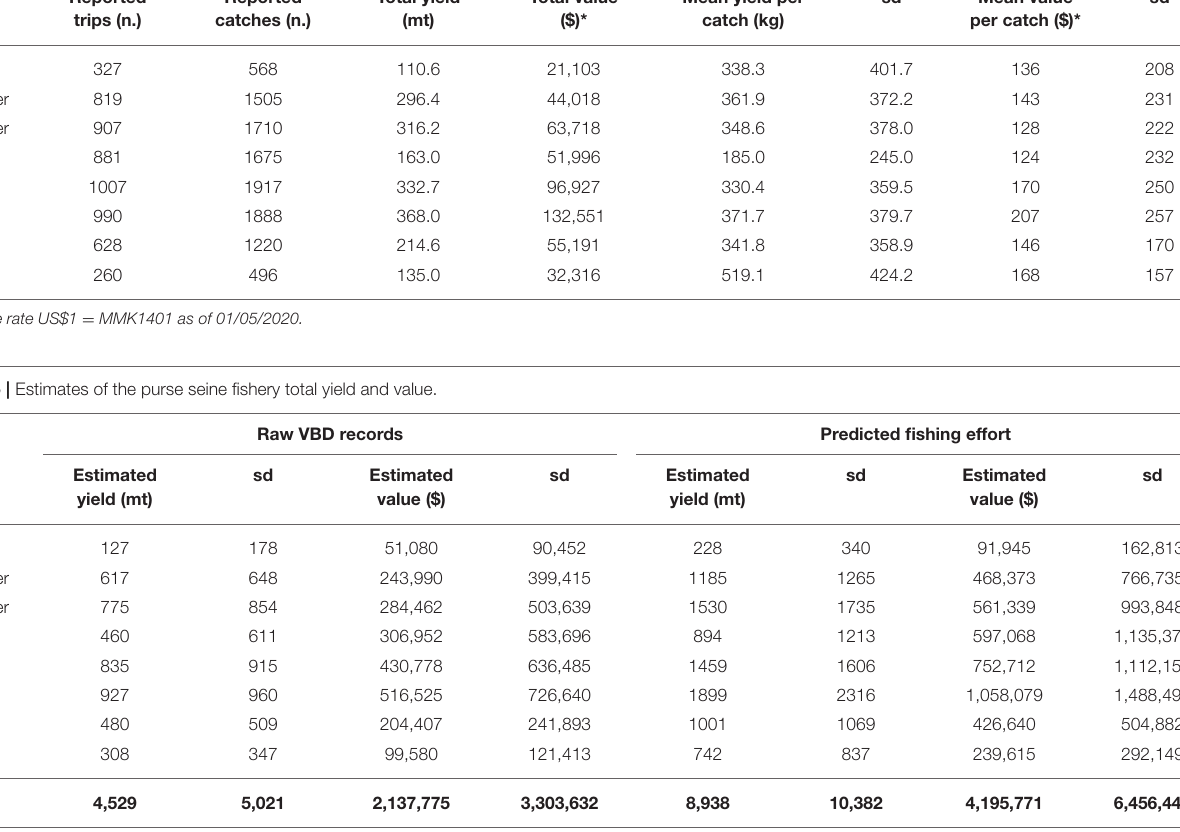
( Figure 4 ). GPS tracks were spatially clustered, with results of the KDE analysis revealing two distinct core fishing areas, cumulatively representing 177 km 2 . Of this, 170 km 2 (96%) spatially intersected the core area identified in the VBD